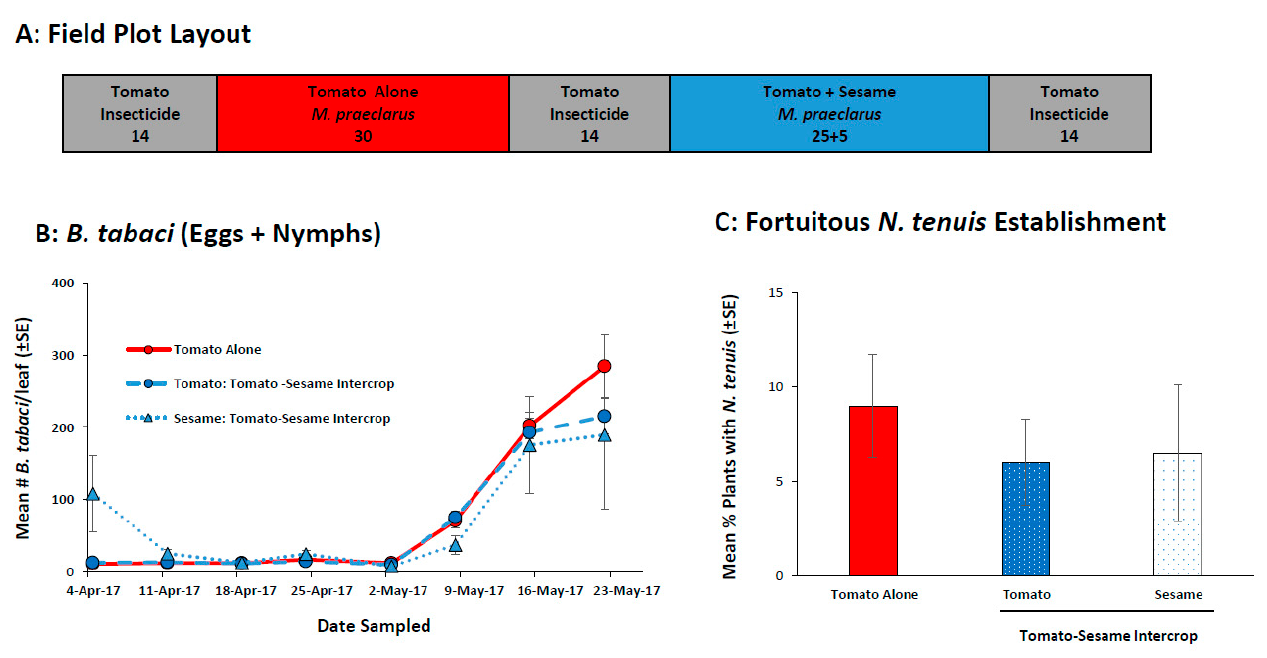
Figure 5. The field plot layout ( A ) and the mean (±SE) number of B. tabaci (eggs + nymphs) per tomato and sesame leaflet ( B ) in a study that tested whether a tomato-sesame intercrop retained M. praeclarus . M. praeclarus were originally released but not recovered and N. tenuis colonized from the surrounding area are reported as the mean (±SE) percentage of tomato ( C ) plants with N. tenuis (adults + nymphs). The number under each field plot treatment ( A ) indicates the number of tomato and sesame plants.